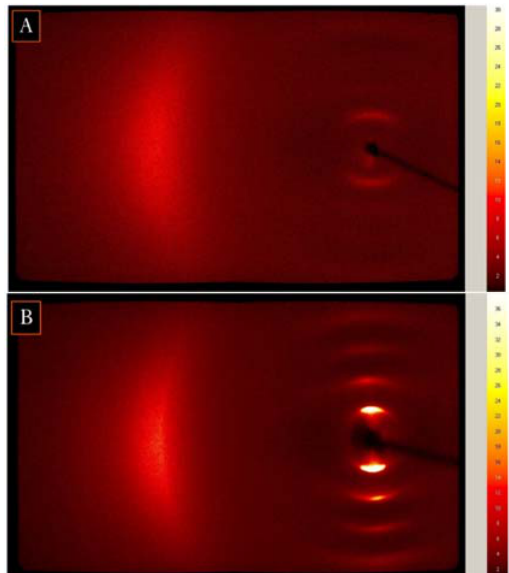
Figure 5. Typical X-ray diffraction patterns: ( A ) monodomain SC-LCE 1 in the nematic phase at 25 °C; ( B ) monodomain SC-LCE 2 in the Smectic A phase at 25 °C.